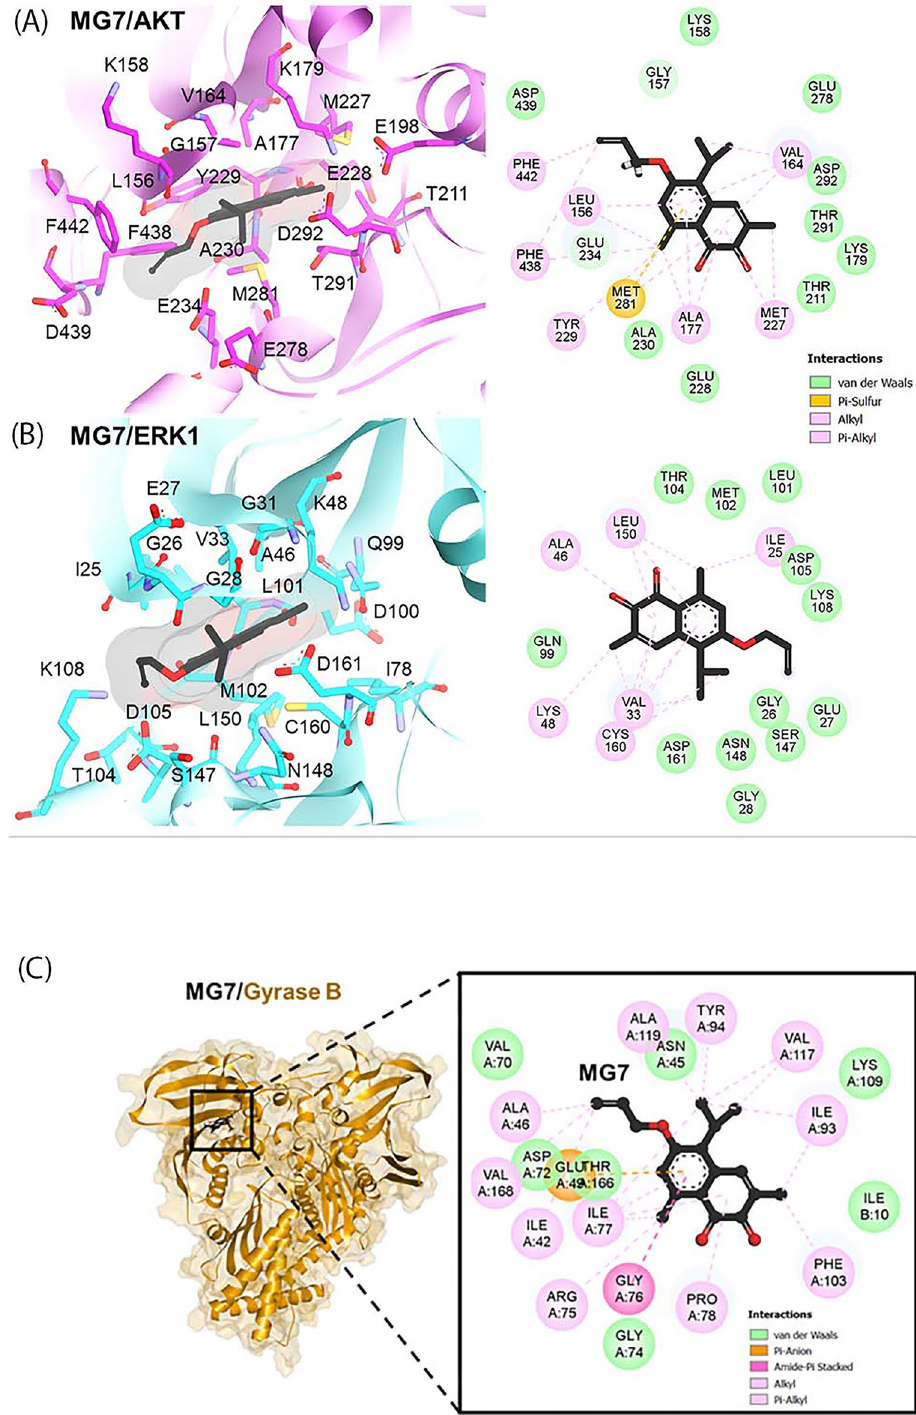
Figure 10. Predicted binding mode of MG7 against ( A ) AKT and ( B ) ERK1 signaling proteins and ( C ) ATPase domain of bacterial DNA gyrase obtained from molecular